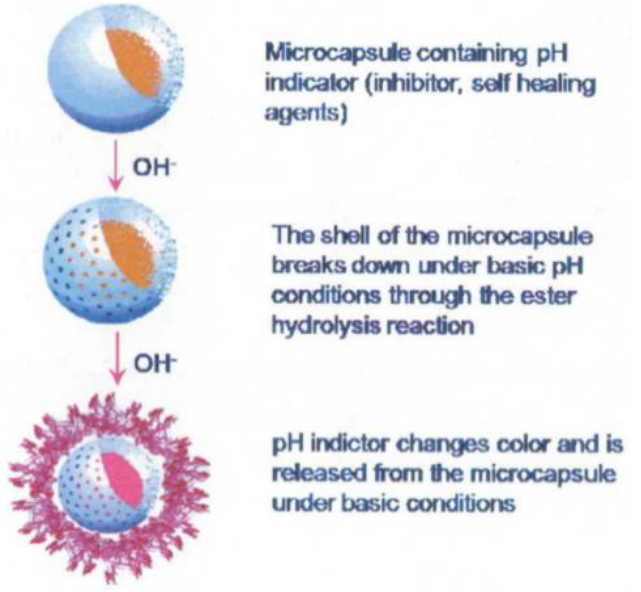
Figure 12. The principle of a smart release pH triggered microcapsule (Reprinted from [59]).